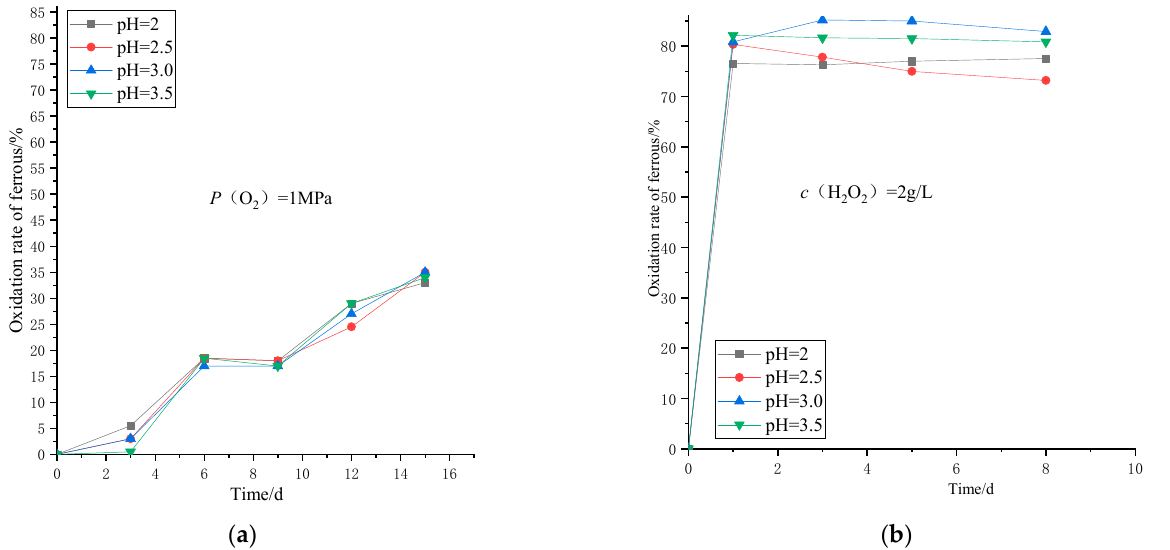
Figure 5. ( a ) Oxidation rate of Fe(II) under different pH with oxygen ( b ). Oxidation rate of Fe(II) under different pH with H 2 O 2 (Fe(II) concentration is 2 g/L).